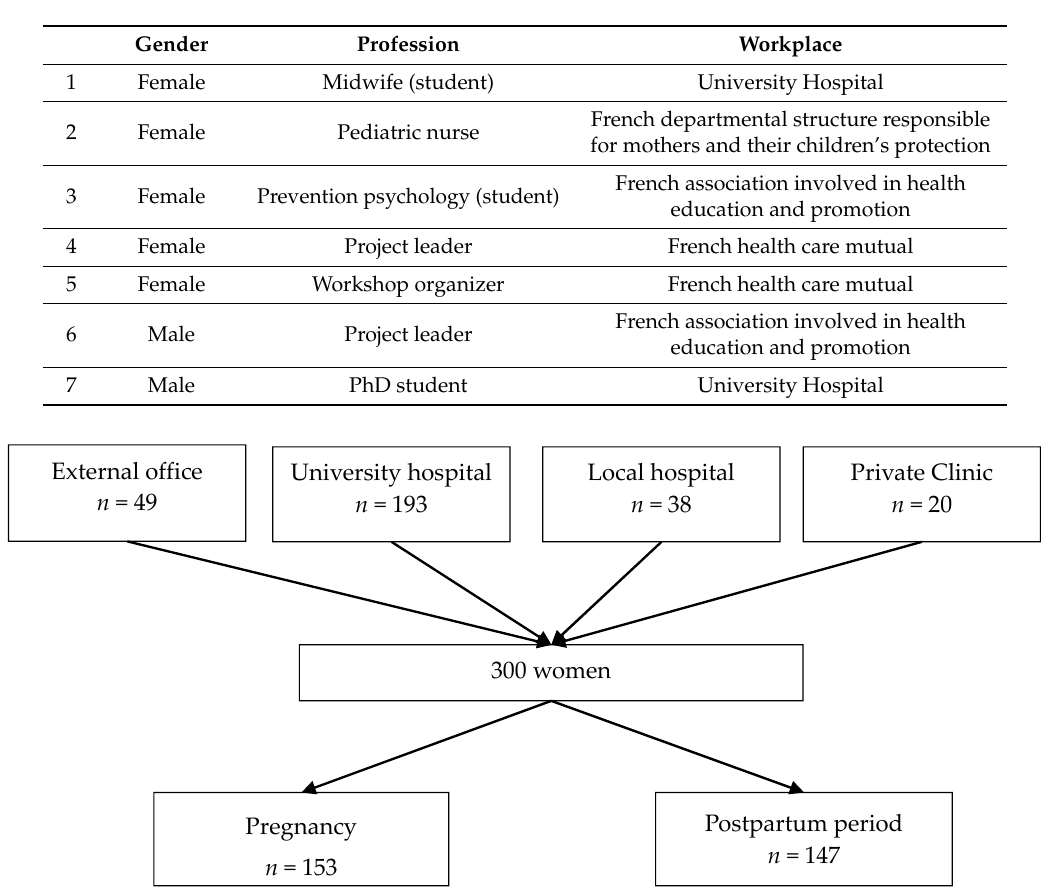
Table A2. Characteristics of the focus group participants.